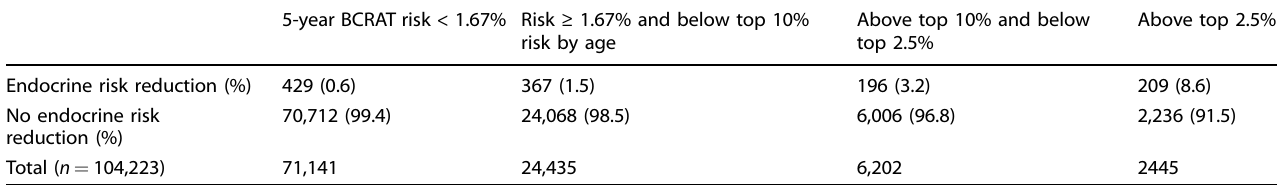
Table 2. Distribution of high-risk women in comparison to other risk strata.